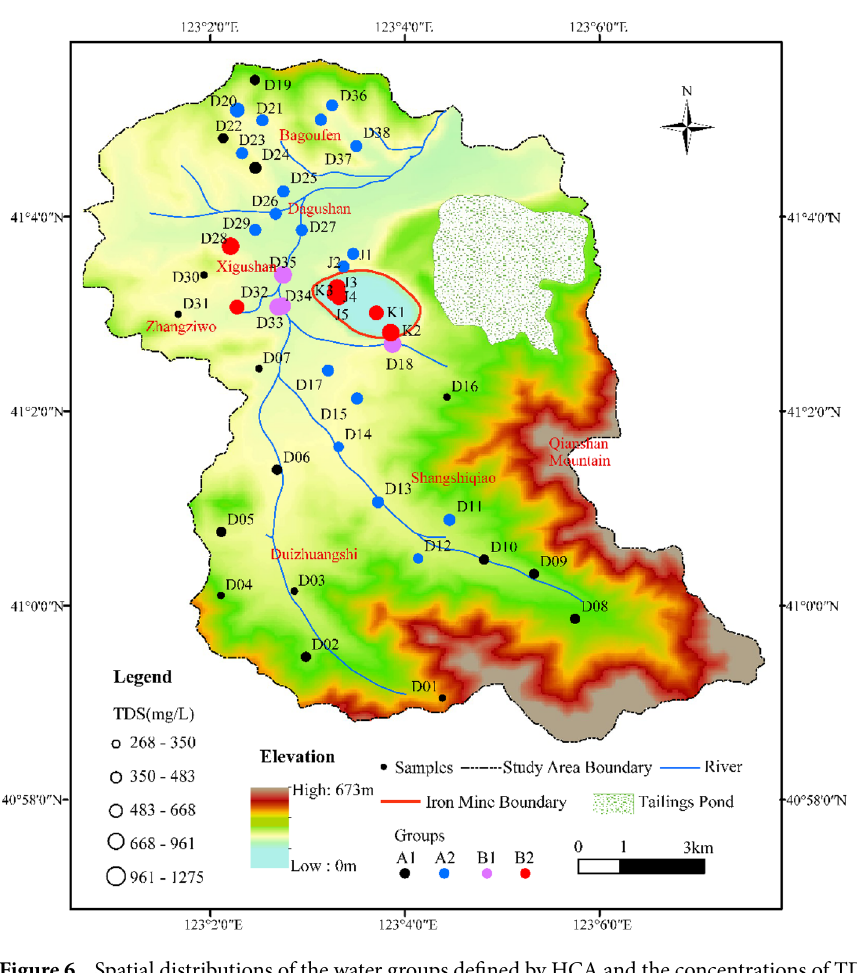
Figure 6. Spatial distributions of the water groups defined by HCA and the concentrations of TDS in the water samples. The diagram was generated using ArcGIS 10.2 (https:// www. esri. com).